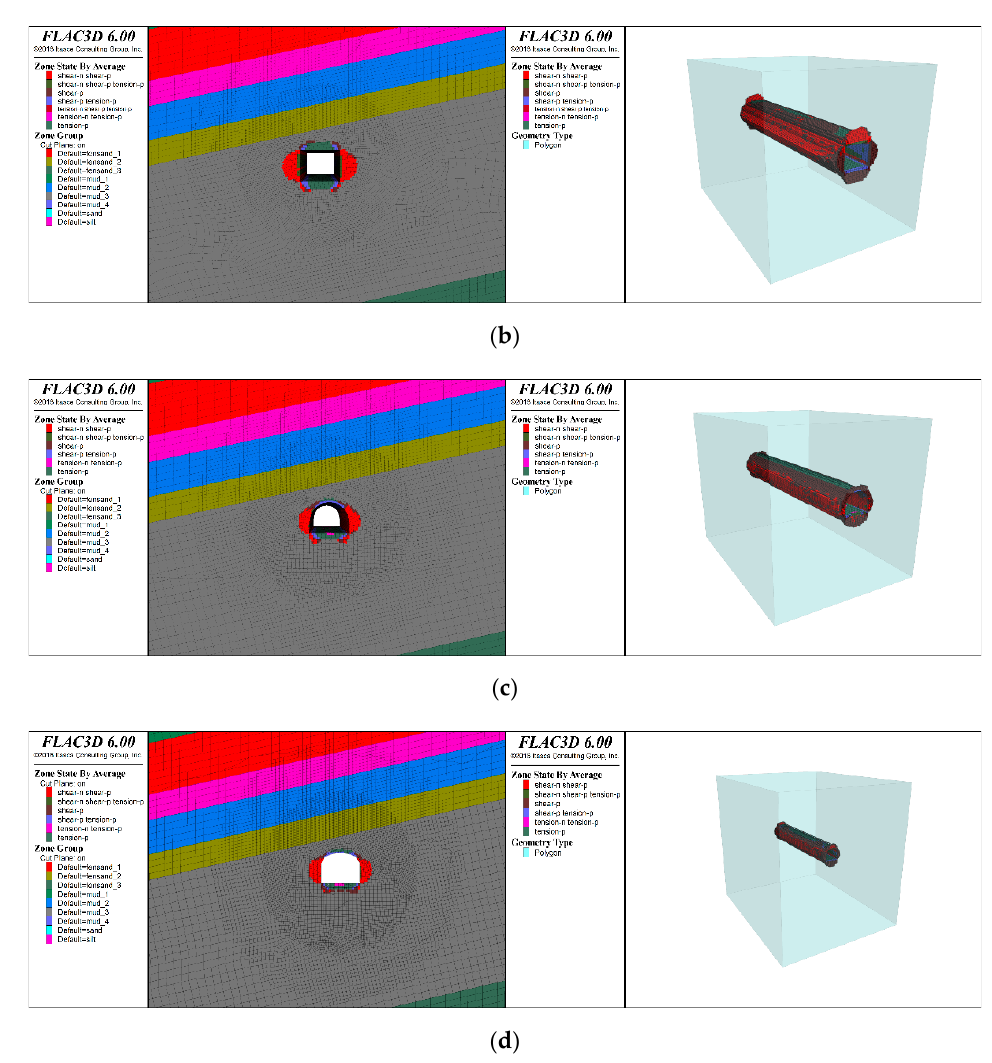
Figure 7. Influence of section shape on the damage zone morphology of the rock surrounding a bottom drainage roadway. ( a ) Circular section; ( b ) Rectangular section; ( c ) Semicircular arch section; ( d ) Three-center arch section.